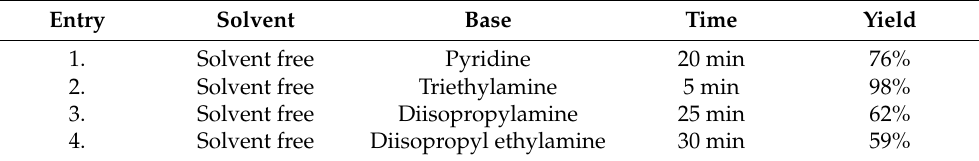
Table 2. Dehydration of N -(3-bromophenyl)formamide under different basic conditions.